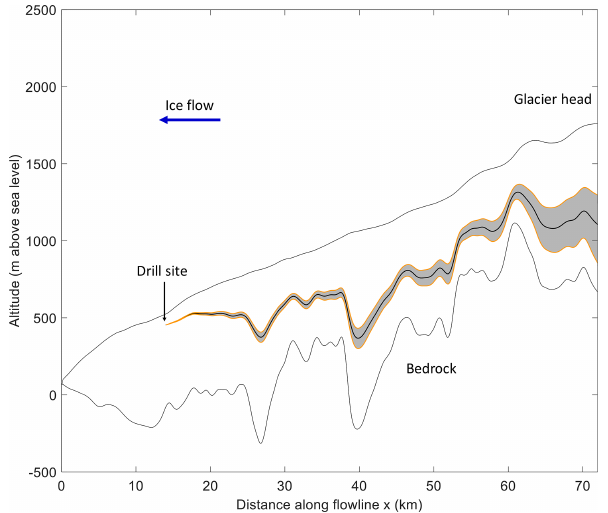
Figure 5. Example of the ice parcel back-trajectory and associ- ated uncertainties. For the Monte Carlo estimate of uncertainties (Sect. 5.4.2), for each given sample depth (72m in this figure), 10000 back-trajectories are generated. Each back-trajectory corre- sponds to a different ablation rate scenario (the ablation rates are perturbed within their experimental measurement uncertainties to generate the scenarios). The shaded region represents the 68% CI uncertainty envelope of the flow